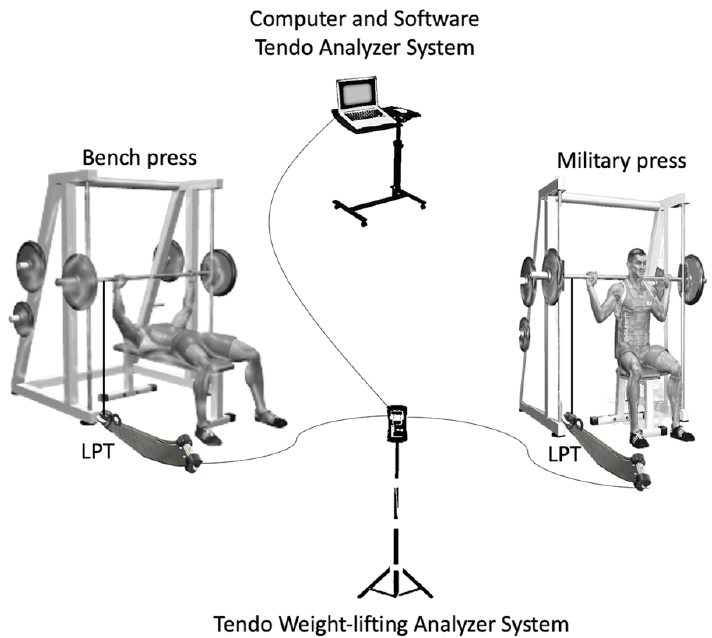
Figure 1. Distribution and location of the Tendo Weightlifting Analyzer System on the Smith machine in the bench press and military press exercises. Abbreviations: LPT = linear position trans- ducer.